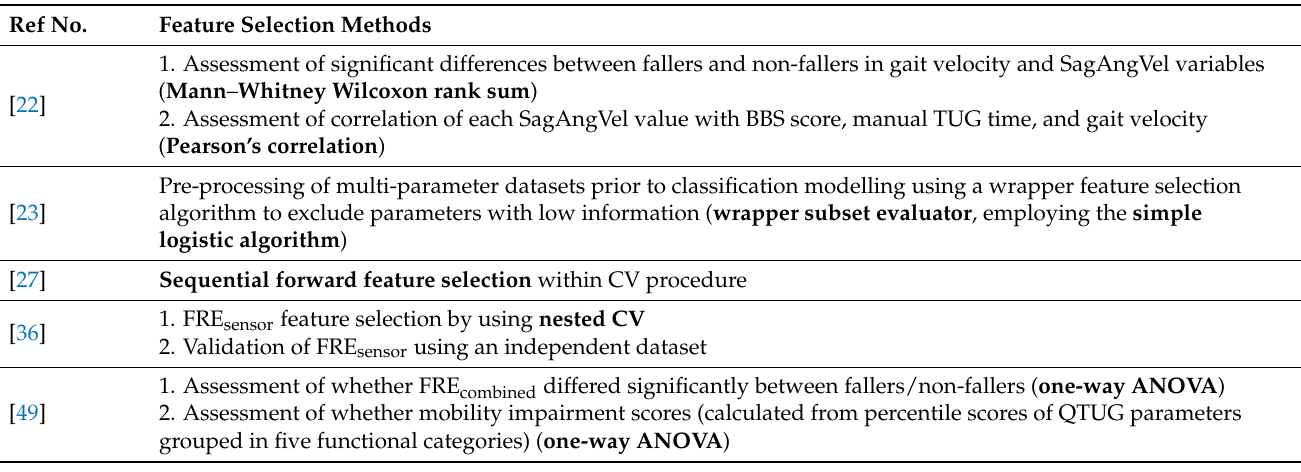
Table A3. Complimentary information for the feature selection methods in Table